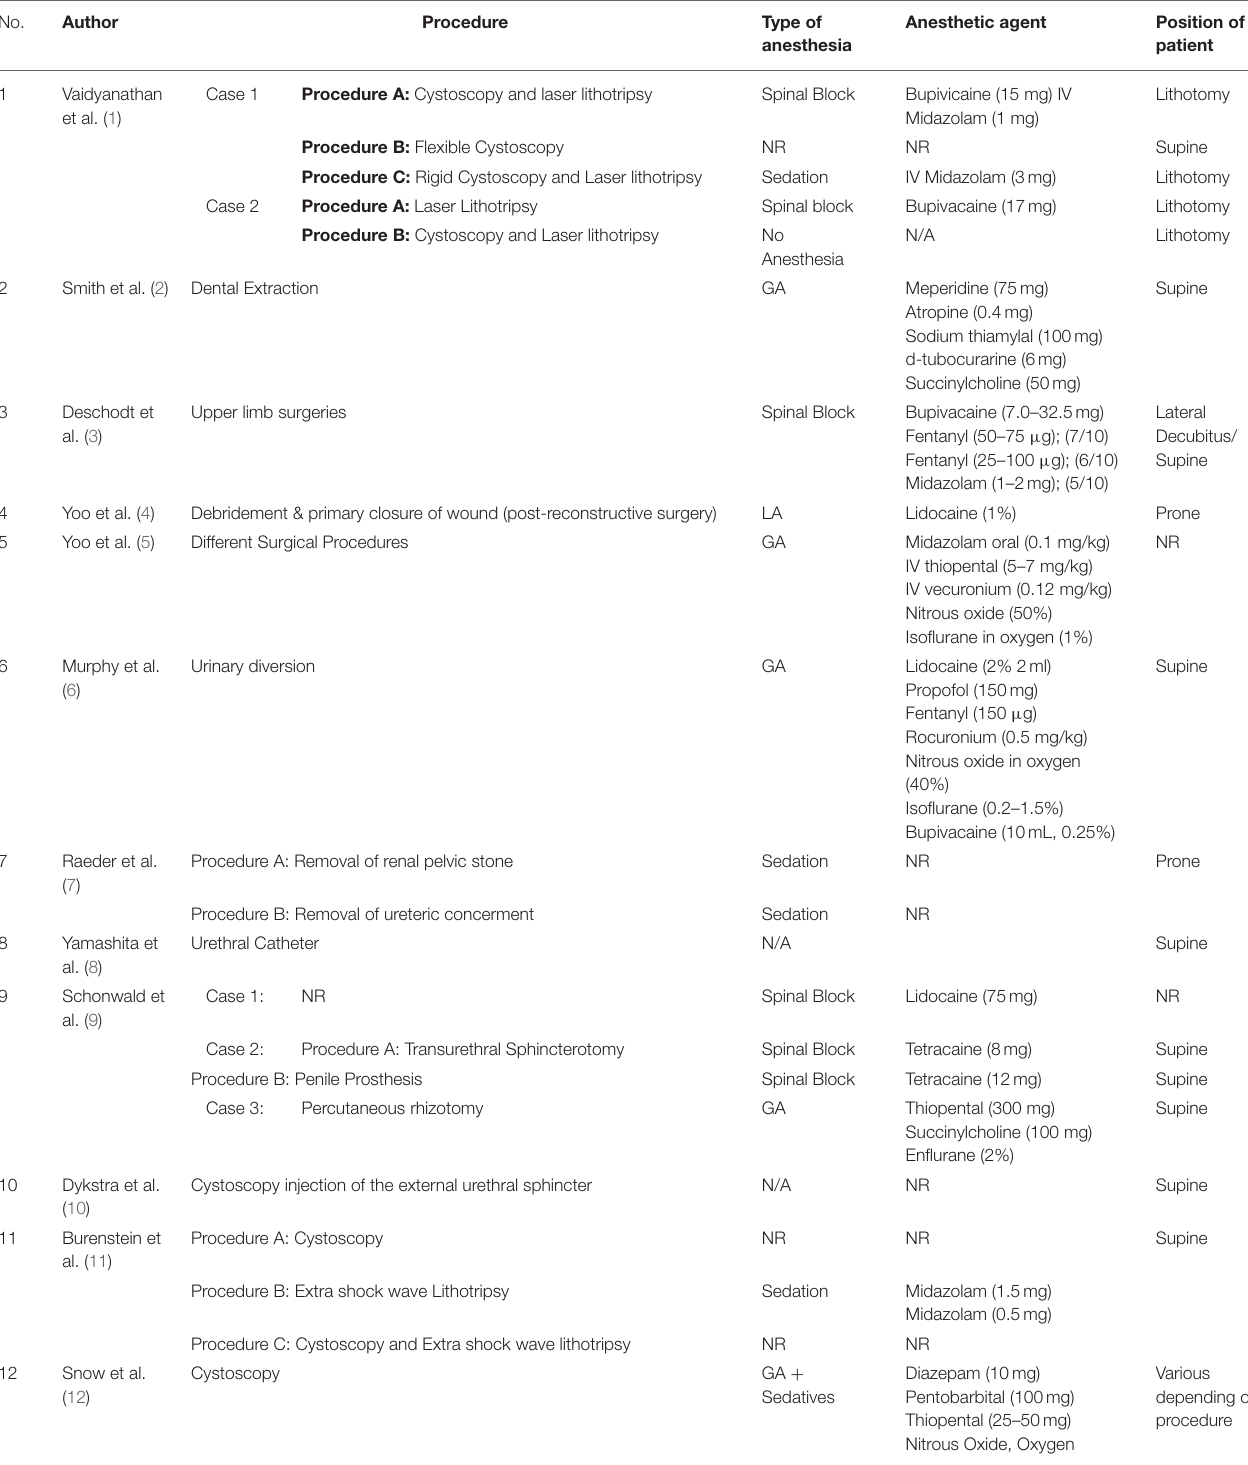
TABLE 2 | Intra-operative characteristics.